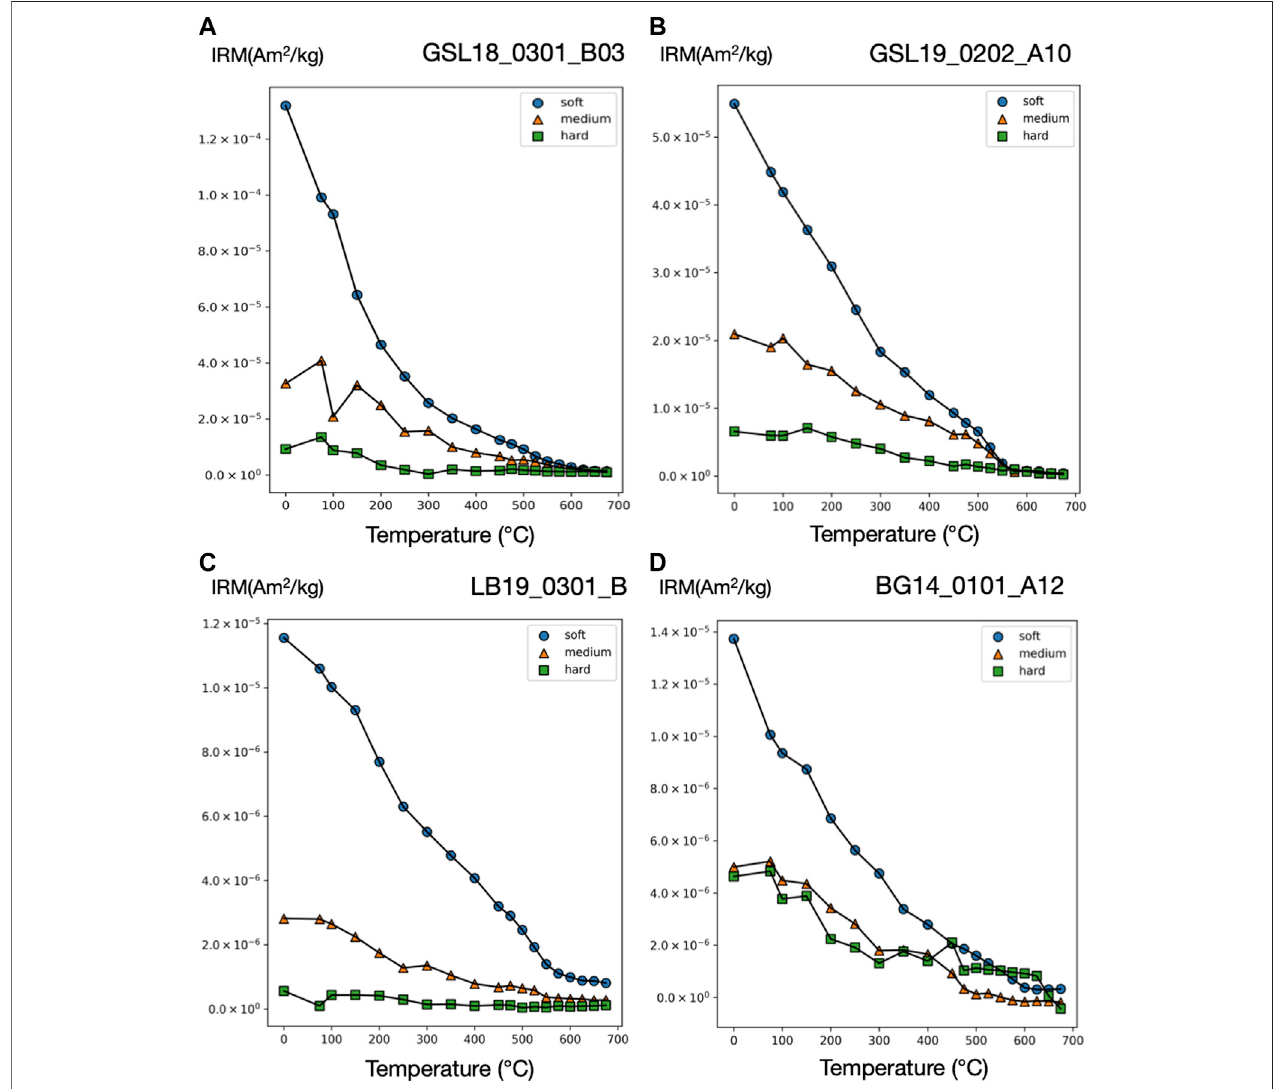
FIGURE 4 | Three-component IRM technique thermal demagnetization results for microbialite samples (A) GSL18 (B) GSL19 (C) LB19, and (D) BG14. Three- componentIRM(Am 2 /kg) producedwithapplied fi eldof100 mT(soft),300 mT(intermediate),and1,000 mT(hard).Soft,medium,andhardfractions areshownasblue circle, orange triangle, and green square, respectively. Additional plots are included in Supplementary Figure S4 .